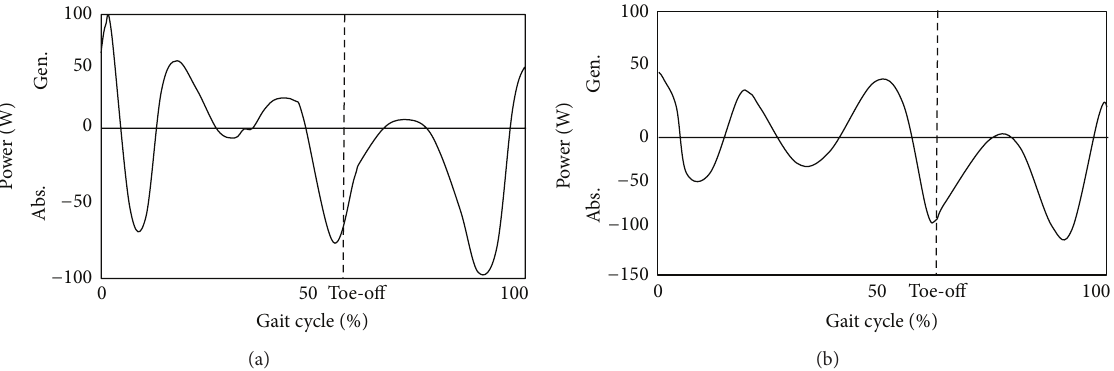
Figure 3: Knee power during normal walking, (a) and (b) [6, 38], respectively.